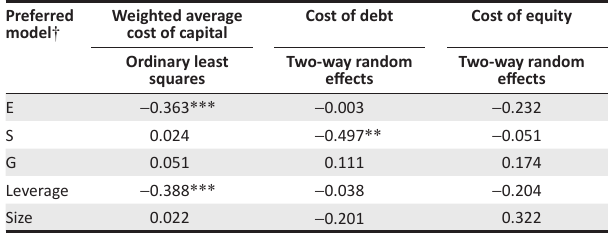
TABLE 4: Regression results for the individual environmental, social and corporate governance disclosure scores for the consumer goods